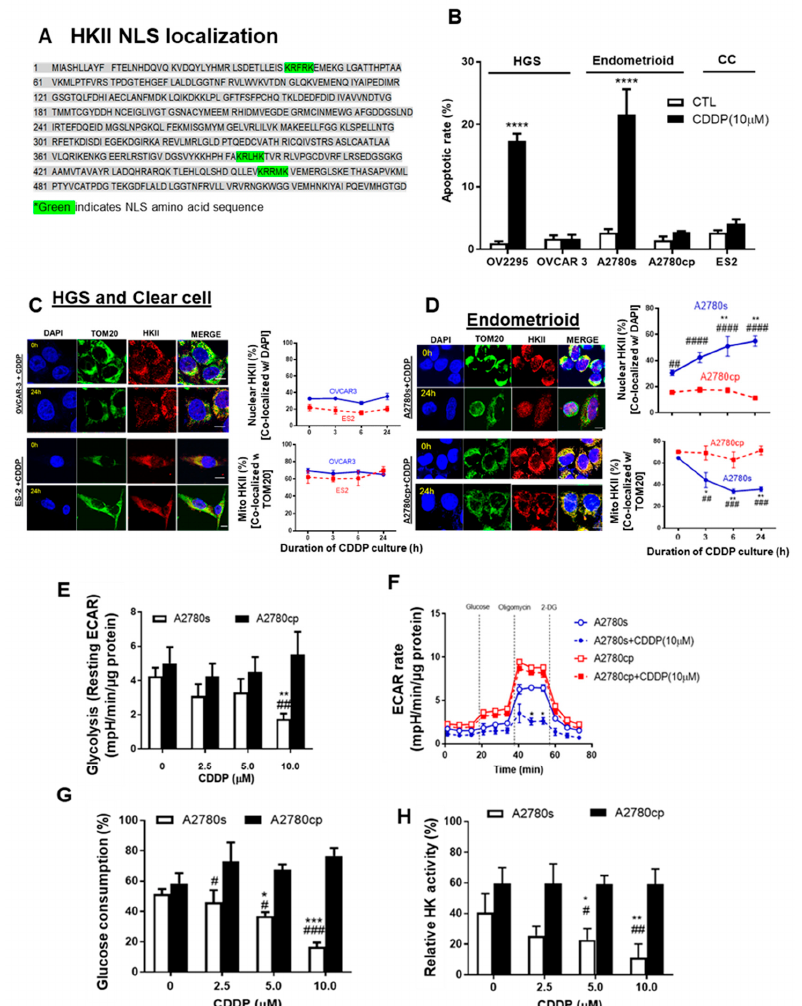
Figure 3. Mito-HKII is associated with chemoresistance and glycolysis in EOC. ( A ) Monopartite nuclear localization signal (NLS) present in the amino acid sequence of HKII (locus: XP_011531109). ( B ) High-grade serous (HGS; OV 2295, OVCAR-3), endometrioid (A2780s, A2780cp cells), and clear cell (CC: ES2 cells) lines were cultured with CDDP (0–10 µ M; 0–24 h; DMSO as a vehicle), and apoptosis was measured using nuclear Hoechst staining. ( C , D ) EOC cell lines (OVCAR-3, ES2, A2780s, A2780cp) were treated as described in ( A ) and examined with confocal microscopy. Cellular localization of HKII (red; as % of total cells), TOM20 (green: mitochondrial marker), and DAPI (blue: nucleus marker) were analyzed using an Image Premier program. ( E ) A2780s and A2780cp cells were treated with CDDP (0–10 µ M; 24 h; DMSO as a vehicle), and glycolysis (resting extracellular acidification rate (ECAR)) was measured. ( F ) ECAR was assessed over 72 min in cells treated after exposure to biomodulators (dashed vertical line). ( G , H ) A2780s and A2780cp cells were cultured as in ( G ), and glucose consumption ( C ; spent medium), and HK activity ( H ; cell lysates) were measured. Error bars denote mean ± SEM ( n = 4). (* p < 0.05, ** p < 0.01, *** p < 0.001, **** p < 0.0001, CTL vs. CDDP; # p < 0.05, ## p < 0.01 ### p < 0.001, #### p < 0.0001, A2780s vs.